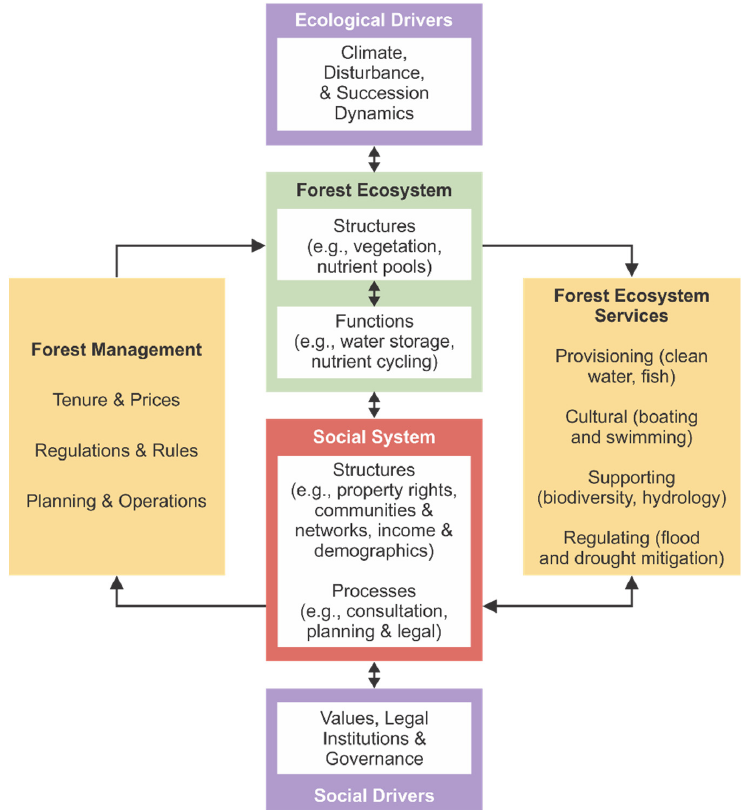
Figure 3. Forest aquatic ecosystem services are part of a socio ‐ ecological system. Modified from [41].